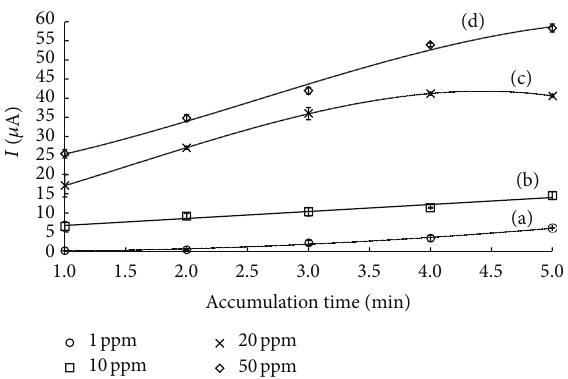
Figure 4: The effects of accumulation time (1 to 5 minutes) for the Acetabularia -CPE for Pb(II) standard with concentrations of (a) 1, (b) 10, (c) 20, and (d) 50ppm. The applied conditions were deposition potential of − 800 mV and scan rate of 75 mV/s in 0.1MKNO 3 electrolyte.